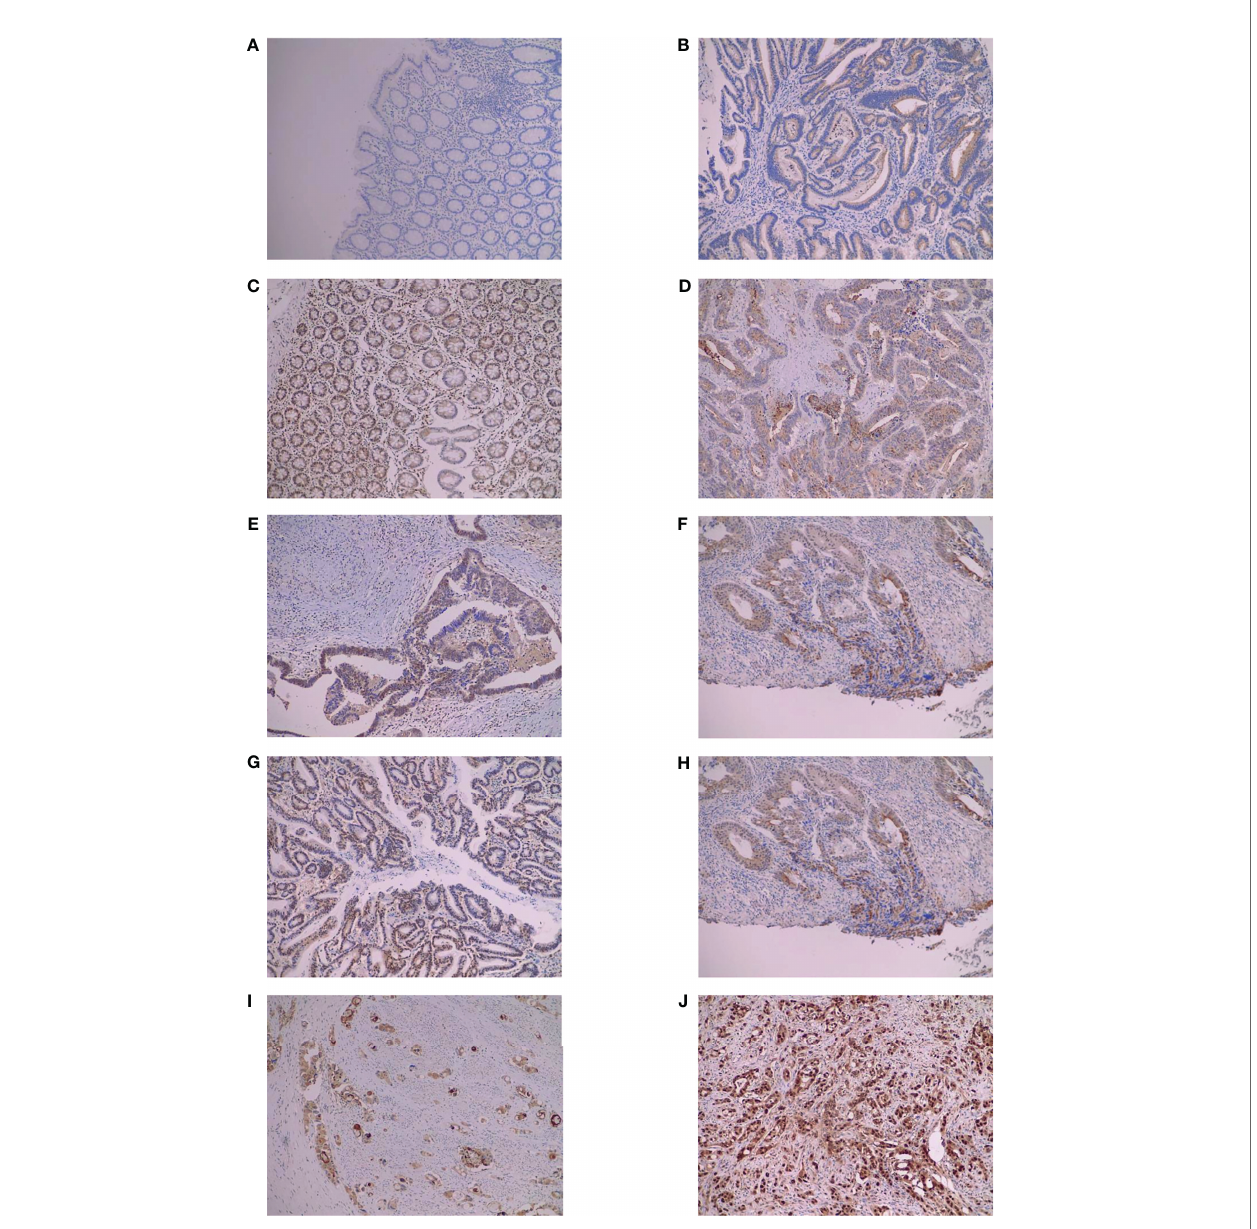
FIGURE 2 | Immunohistochemical staining examples to describe scoring. All pictures are at 10X magni fi cation. (A) Score 0 control cAMP; (B) score 1 tumor cAMP; (C) score 2 tumor OGFR; (D) score 3 tumor MOR; (E) score 4 tumor OGFR; (F) score 4 tumor MOR; (G) score 5 tumor OGFR; (H) score 5 tumor OGFR; (I) score 6 tumor MOR; (J) score 6 tumor OGFR. MOR, µ opioid receptor; OGFR, opioid growth factor receptor; cAMP, cyclic adenosine